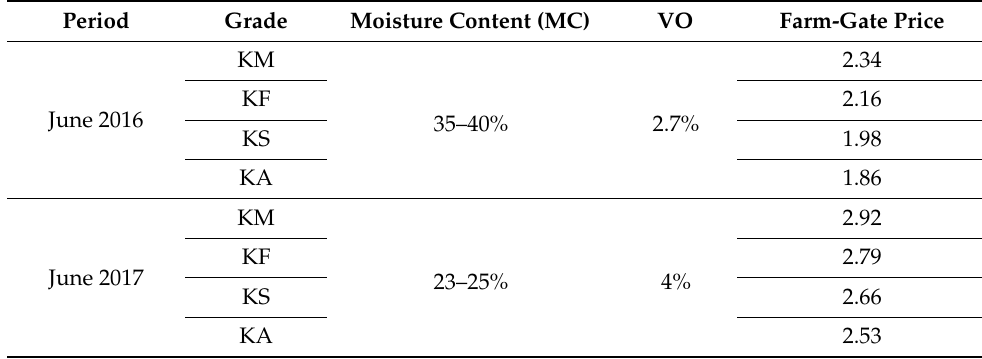
Table 6. Price differentiated over time